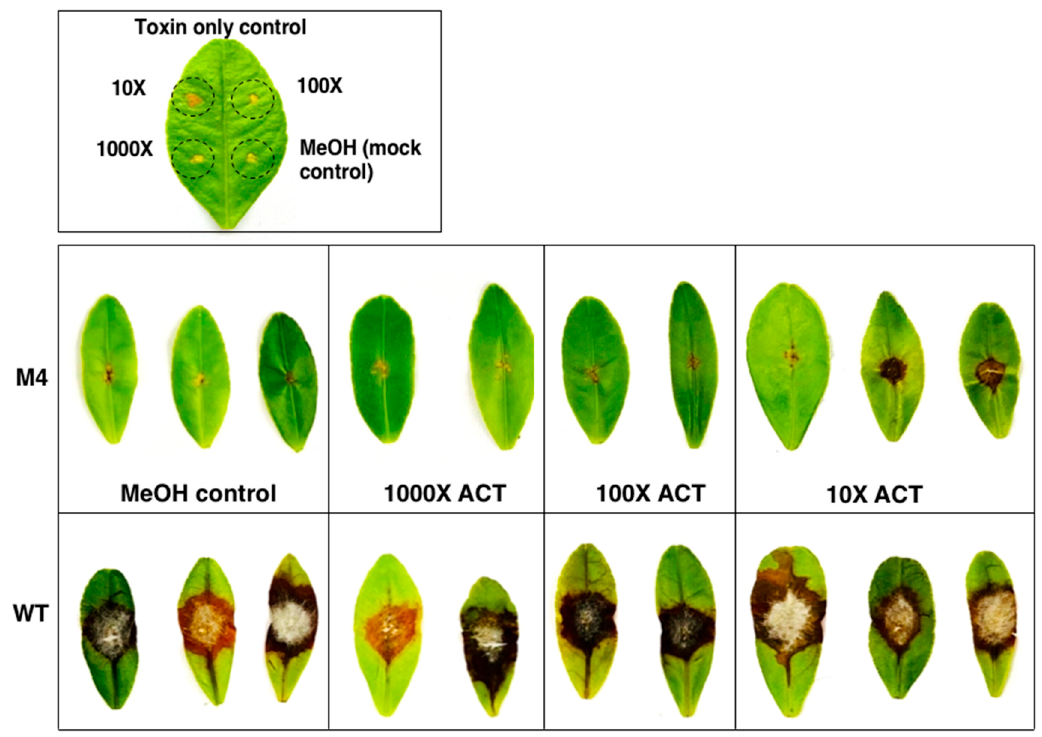
Figure 10. Partial restoration of Δ pex6 virulence with purified toxin. ACT (~12–15 µg toxin/g mycelium) was purified from culture filtrates of wild type grown in potato dextrose broth for 7 days using Amberlite XAD-2 resins and ethyl acetate, dissolved in methanol, diluted (10×, 100×, or 1000× in methanol), and applied onto calamondin leaves that were wounded before treatments. After 30 min, the leaves were inoculated with conidial suspensions prepared from wild type (WT) and the Δ pex6 -M4 mutant. The leaves were maintained in a moisture chamber for 3 days for lesion development.